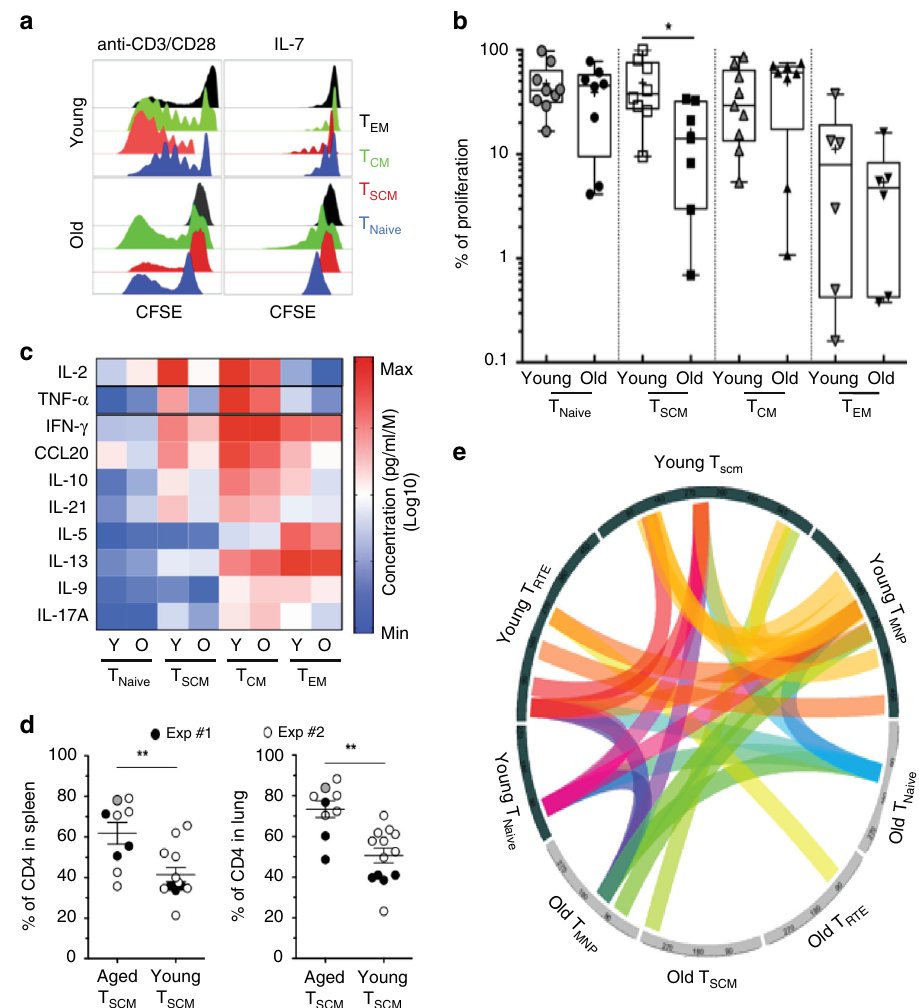
Fig. 4 Functions of T SCM CD4 cells during aging. a Proliferation pro fi le of CD4 T-cell subsets during aging. Representative histogram of CFSE dilution from sorted T-cell subsets collected in young or older donors and stimulated with anti-CD3/CD28 microbeads or IL-7 (10 ng/ml) during 5 days. b Alteration of proliferative potential of T SCM CD4 cells in response to TCR stimulation as measured in ( a ). T-cells subsets were freshly isolated from blood of young and older donors ( n = 8 and 9, respectively). The statistical analysis was performed on unpaired samples ( U Mann – Whitney test) (* for p < 0.05). Source data are provided as a Source Data fi le. c Decreased secretion of homeostatic and effector cytokines by T SCM CD4 cells during aging. Sorted CD4 T-cell subsets were polyclonally stimulated with PMA/Ionomycin. The cytokines concentration was represented by an heatmap to visualize the acquisition of effector functions during differentiation and the speci fi c signature associated with aging ( n = 6 for young and old donors). Source data are provided as a Source Data fi le. d Increased engraftment of human T SCM CD4 cells from aged donors in humanized NOD SCID gamma chain (NSG) mice. T SCM CD4 cells from young ( n = 2) or old donors ( n = 2) were differentiated from T-naive precursors, expanded in vitro before their xenotransplantation into NSG mice ( n = 13 and n = 9, respectively). At 21 (Exp#1) or 28 (Exp#2) days after the human T SCM CD4 cells transfer, animals were killed and euthanized by CO 2 , and tissues were collected (spleen, lungs). N = 2 independent experiments were performed and labeled by the color code on the graph ( fi lled circles: Exp#1; open circles: Exp#2; fi lled gray circle represents the mouse with GVHD signs and killed at day 16). The statistical analysis was performed on unpaired samples ( U Mann – Whitney test) (** for p < 0.01). e Reduced CDR3 diversity in naive CD4 T cells. Naive T-cell subsets were sorted as naive, T RTE , T MNP , and T SCM CD4 cells. The extraction of mRNA was performed just after T-cell sorting, and analyzed by RNA-seq. CDR3 composition was compared between cell subsets and during aging. A connective arc represented high degree of homology (80%) between CDR3 sequences during differentiation and immune stimulation contributes to CD31 shedding 46 . We also seq data and determine CD4 T-cell differentiation trajectory- our observed a positive correlation between the frequencies of T RTE transcriptome supports a model where T RTE could differentiate into T SCM and CD31 neg naive CD4 T cells (Supplementary cells (de fi ned as PTK7 + CD31 + ) at day 0 and the frequencies of induced T SCM at day 7 (Fig. 6d), supporting the idea that T SCM Fig. 7E). Due to the overlapping features of T RTE and T SCM with age, could be derived from T RTE cells. This hypothesis was evaluated in silico by STEM analysis of naive CD4 T-cell subsets particularly the loss of Wnt/ β -catenin pathway activity with age — (Supplementary Fig. 7C, D). The dynamics of gene expression we speculated that high CD31 expression could reduce the between T RTE and T SCM CD4 cells was a more plausible outcome threshold of naive CD4 T cells to differentiate into T SCM via the than comparisons of other putative ontogenic pathways. Next, Wnt/ β -catenin activation (Fig. 6e). We observed that, indepen- Monocle was used to generate pseudotime from single-cell RNA- dent of donor age, 5 μ M of TWS119 concentration could